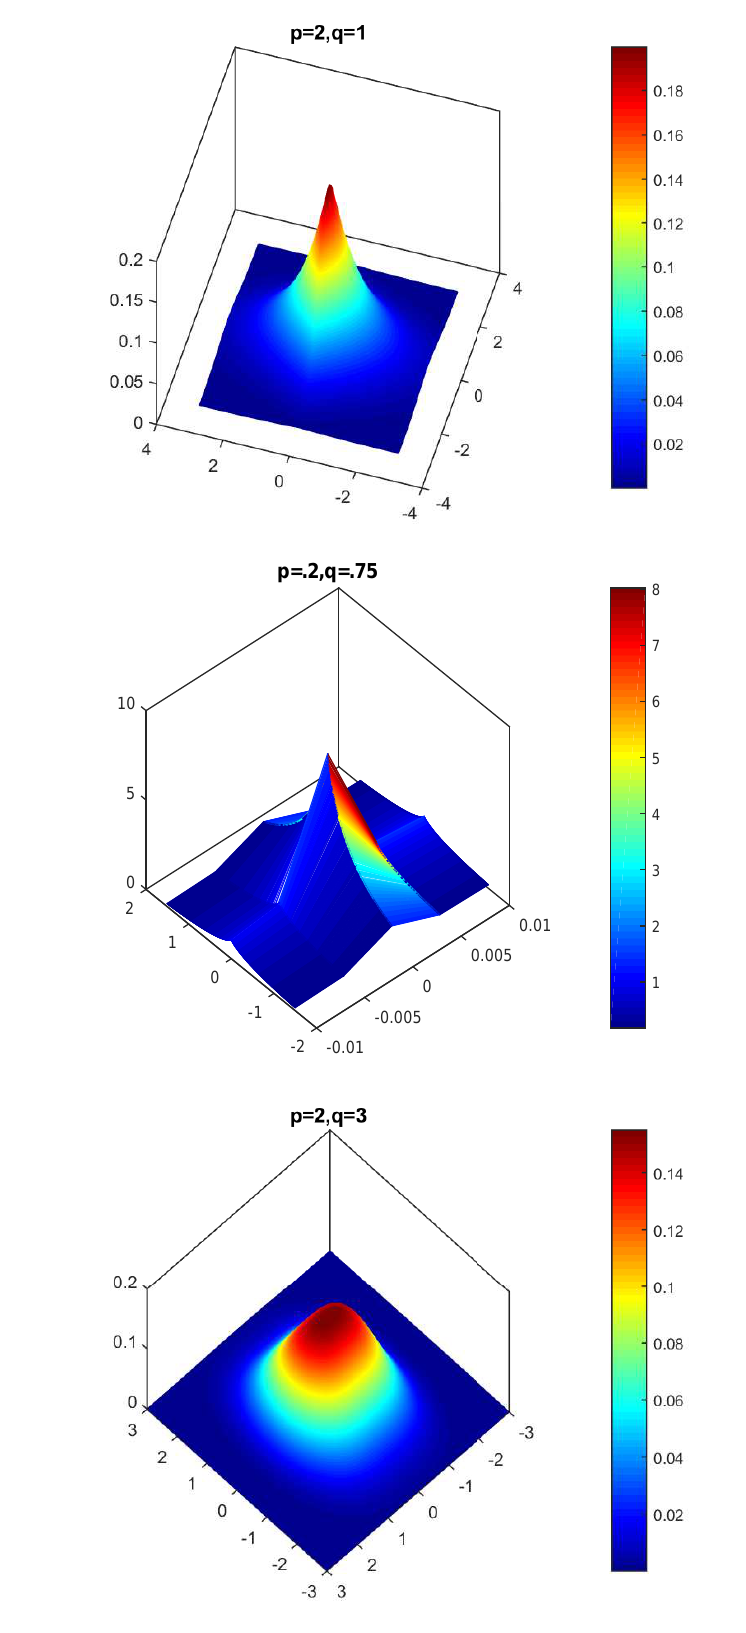
Figure 1. ( p , q ) -spherical